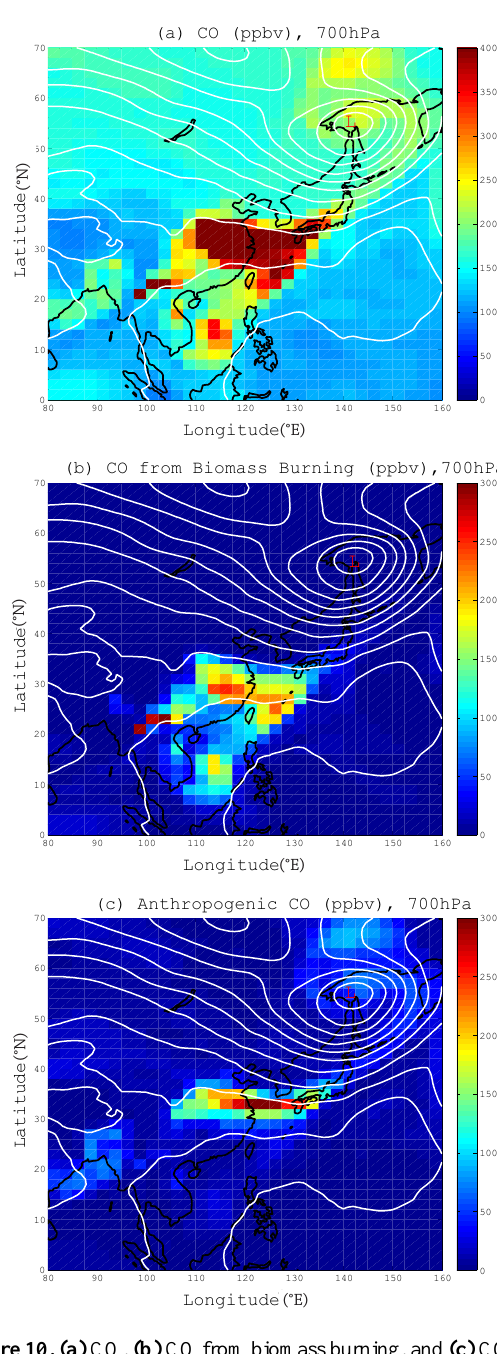
The vertical velocity reached 0.2 m s − 1 in FNL data around this level (not shown). The ECMWF (European Centre for Medium-Range Weather Forecasts) data also show north- eastward airflow from Indochina peninsula with high poten- tial energy (warm and wet) available for strong